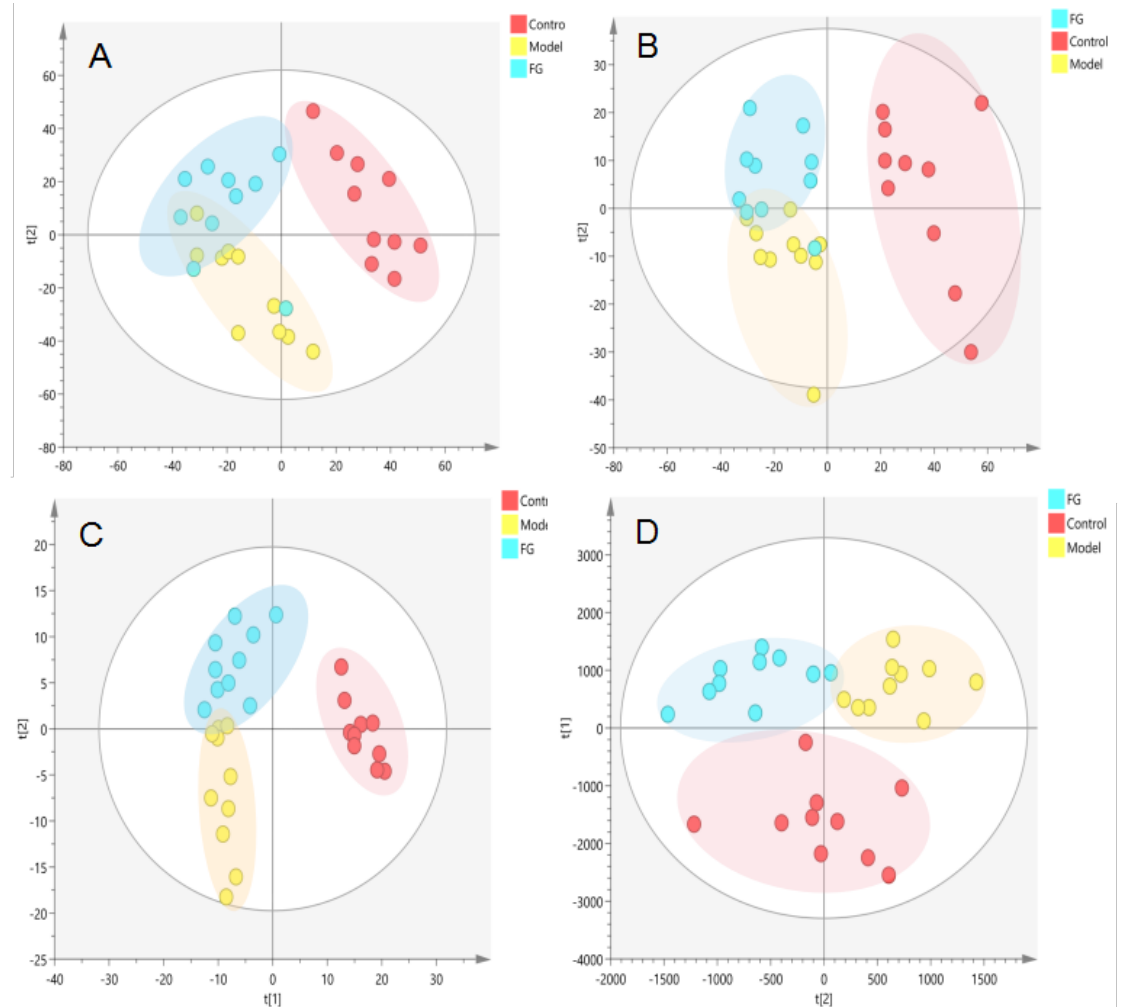
Figure 9. Metabolic profile in the serum of the T2D db/db mice treated with GG polysaccharide (( A ). NEG, PCA; ( B ). POS, PCA; ( C ). NEG, PLS-DA; ( D ). POS, PLS-DA).